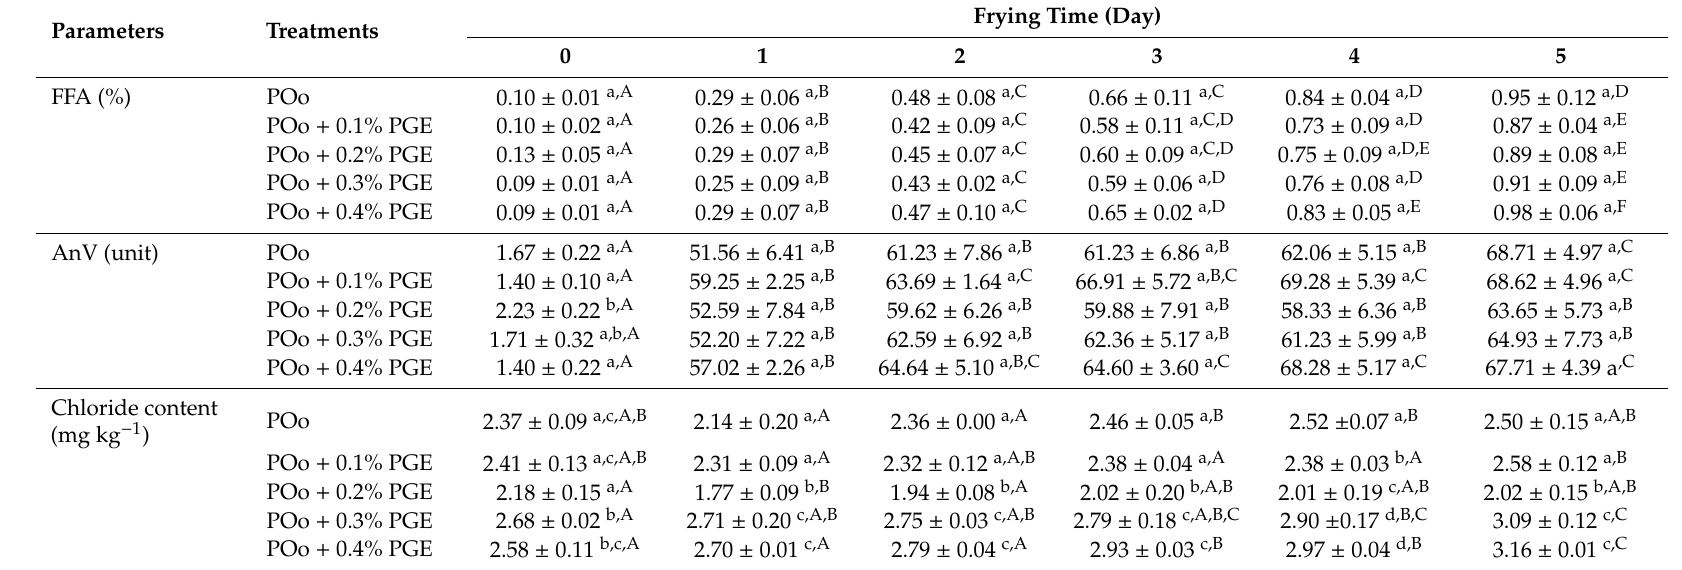
Table 2. Changes of FFA, Totox value and total chlorine in POo added with PGE during repeated frying.